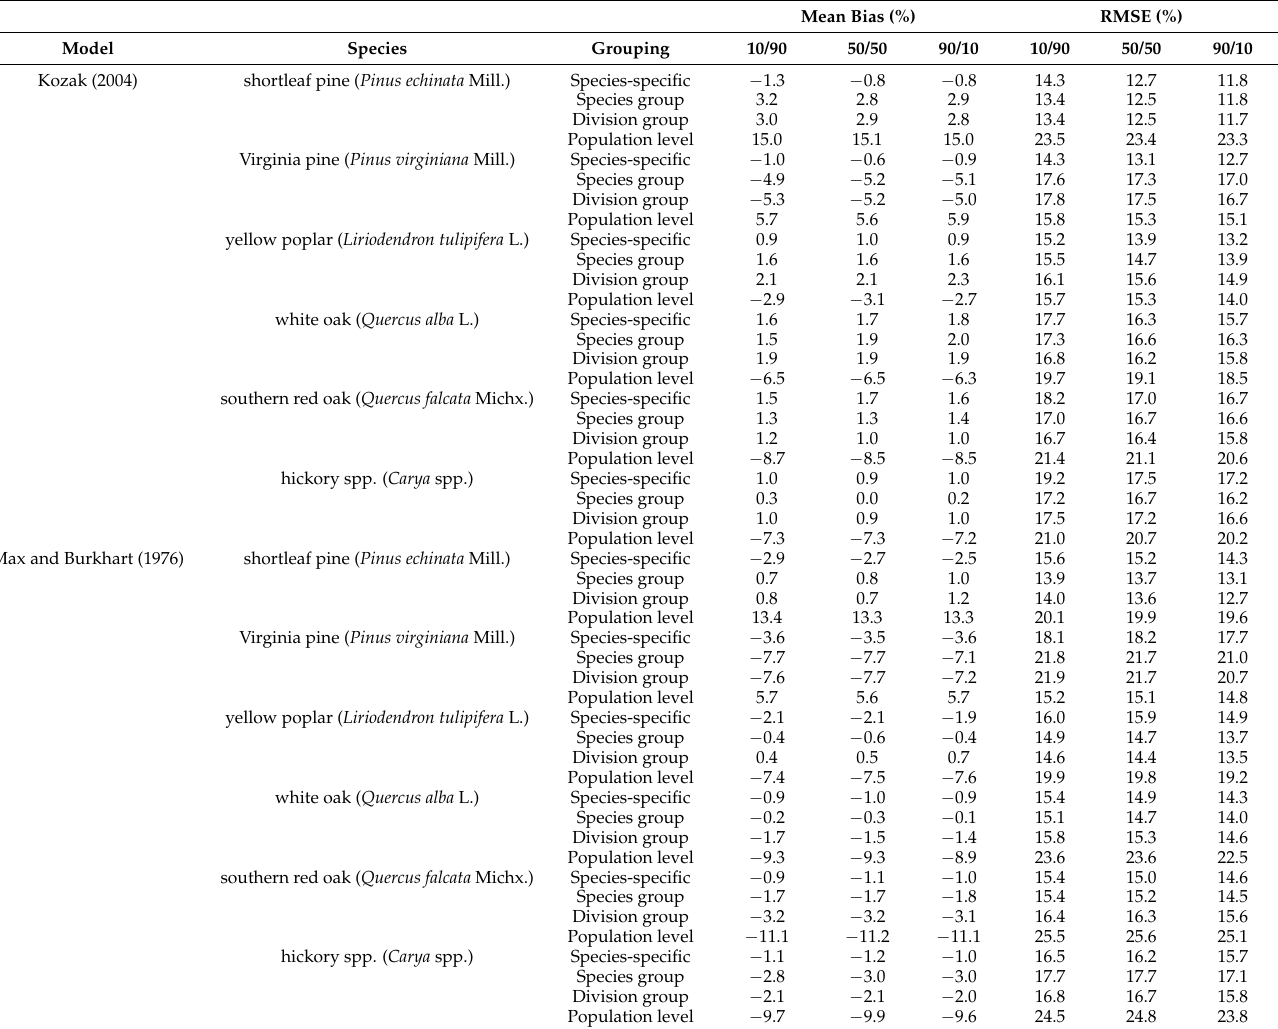
Table 2. Summary of percent mean bias (MB) and percent root mean square error (RMSE) for validation among six species by Kozak (2004) and Max and Burkhart (1976) models. Fitting/validation datasets were split as 10/90, 50/50 and 90/10 (%),